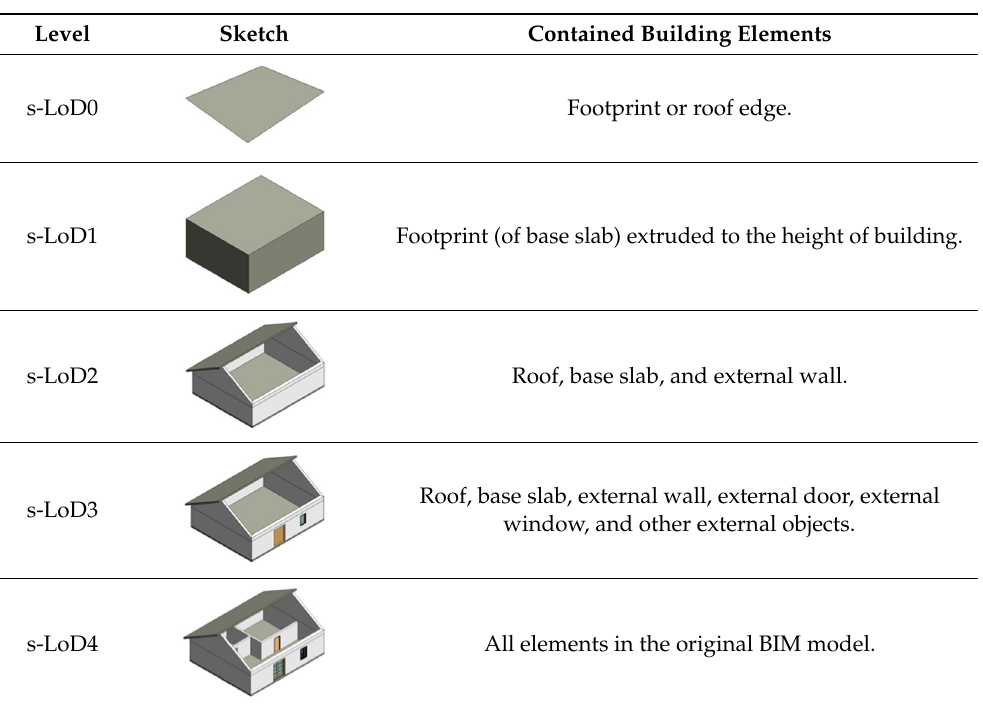
All elements in the original BIM